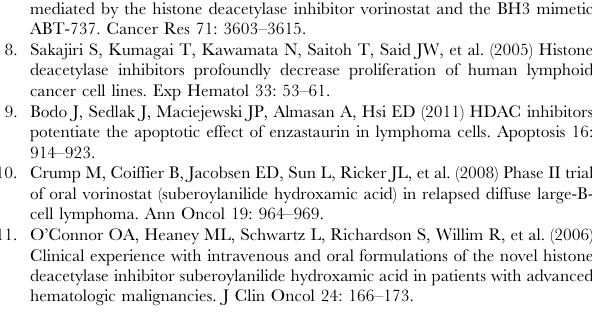
Figure S1 Expression of individual BCL-2 family mem- bers does not correlate with HDACi sensitivity in DLBCL cell lines. Eight DLBCL cell lines were probed for expression of the anti-apoptotic proteins BCL-2, BCL-XL, and MCL-1, the apoptosis sensitizers BIM, HRK, and BID, and the pro-apoptotic activator BAX. Also included in this screen were effector caspase-3 and -8 and b -tubulin (as a loading control). Figure S2 Expression of common DLBCL protein markers does not correlate with HDACi sensitivity in DLBCL cell lines. Western Blotting was performed for the indicated protiens in eight DLBCL cell lines. b -tubulin was used as a loading control. Table S1 Quantification of the extent of PARP cleavage in Fig. 3. HDACi-induced PARP cleavage is decreased by over- expression of BCL-2 or BCL-XL and increased by over-expression of BIM. The numbers represent the percentage of HDACi- induced PARP cleavage as quantified from the bands in the Western blots in Figure 3 using ImageJ. Breifly, band intensities of cleaved and uncleaved PARP were added together to give the total PARP for each sample. The percentage of cleaved PARP was then calculated by dividing the value of the cleaved PARP (lower band) by the total